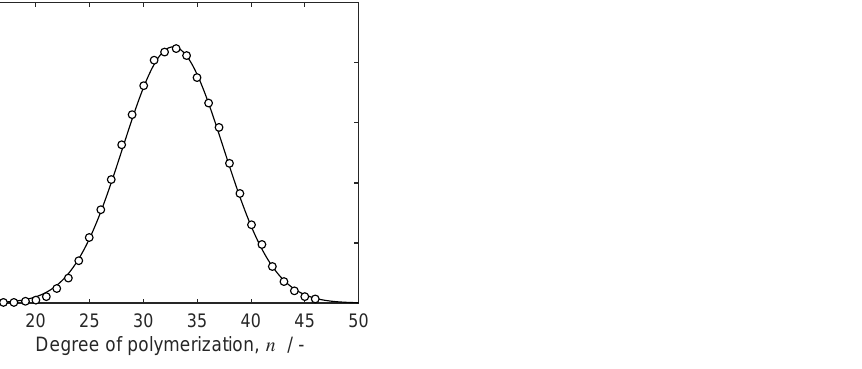
Figure 2. Molar weight distribution of PEG1400 determined chromatographically (symbols) and interpolation by Gaussian normal distribution (line; mean value 32.754, standard deviation 4.676). Measured at 44 ◦ C and 25vol % ACN in